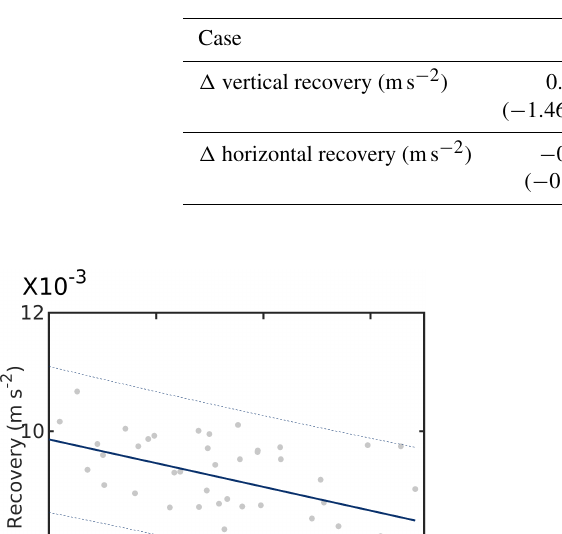
Table 5. Change (TKE advection “off” – TKE advection “on”) in vertical recovery ( × 10 − 3 ; ms − 2 ) and horizontal recovery ( × 10 − 3 ; ms − 2 ), averaged over the 50km × 50km wind farm, the 48h simulation period, and cases A–C. The numbers in the parentheses give the percentage change in recovery with respect to the corresponding momentum loss rate. Asterisks ( ∗ ) denote that the numbers are significant at p < 0 . 01.